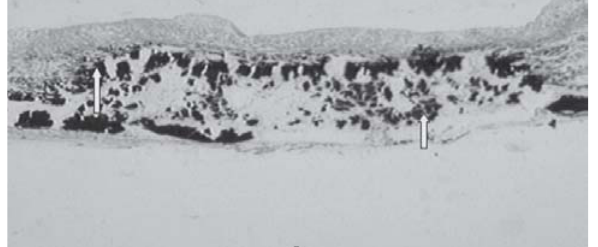
Fig. 6 - Fotomicrografia mostrando corte transversal da cúspide do heteroenxerto valvar pulmonar porcino tratado com glutaraldeído, com sinais de importante calcificação após 210 dias de implante (von Kossa 40X)